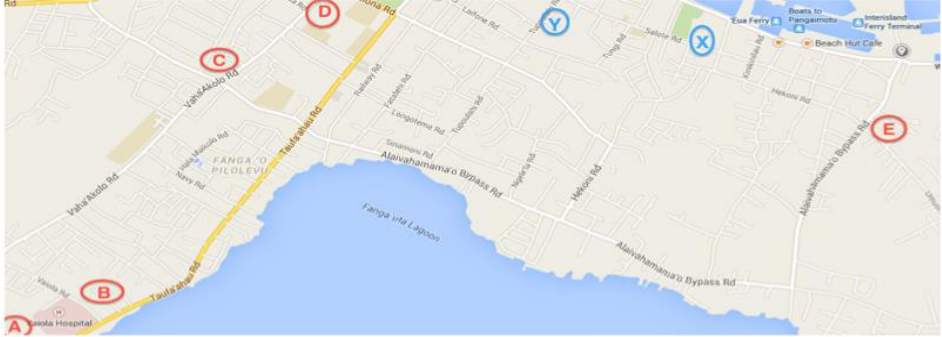
Figure 1 . Locations of schools in Nuku'alofa, capital city of the Kingdom of Tonga. Image source: